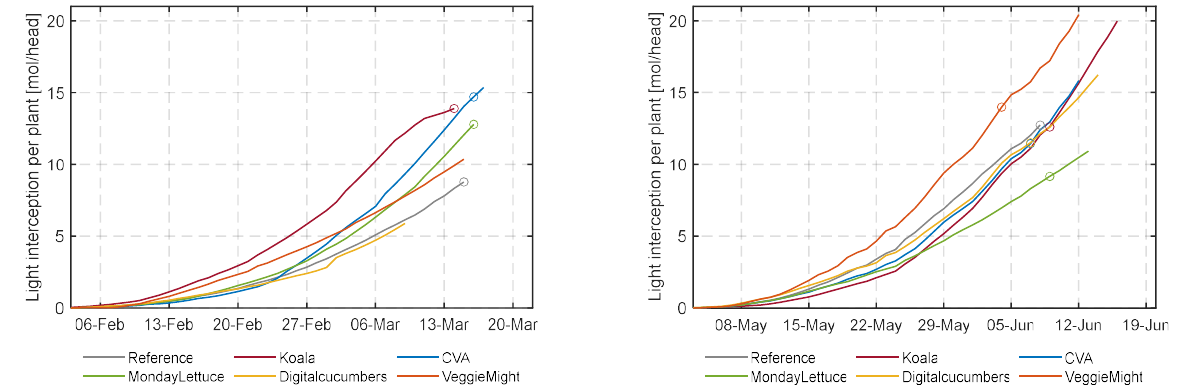
Figure 10. Cumulative light intercepted by each lettuce head per compartment in the first and second cultivation. Light interception per lettuce head was calculated by a multiplication of the daily light integral (DLI) with the green coverage per m 2 growing area, divided by the head density on each particular day. The circles (o), mark the days at which the lettuce heads reached the target fresh weight of 250 g by linearly interpolating the data of the weekly destructive measurements on randomly selected lettuce heads. Table 1. The average density of lettuce heads for the two cultivations as calculated using Equation